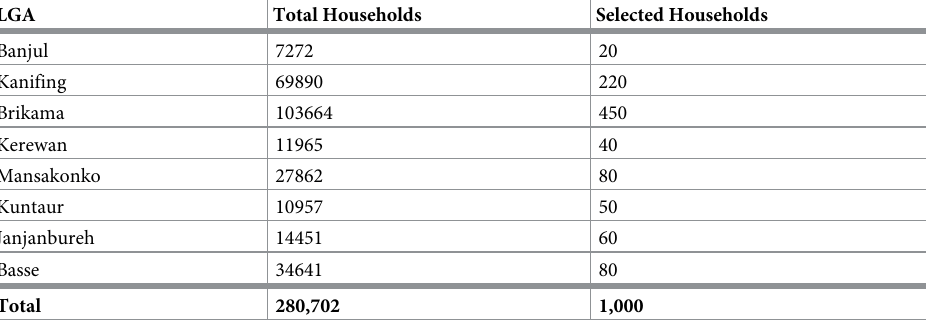
Table 2. Distribution of selected households per local government